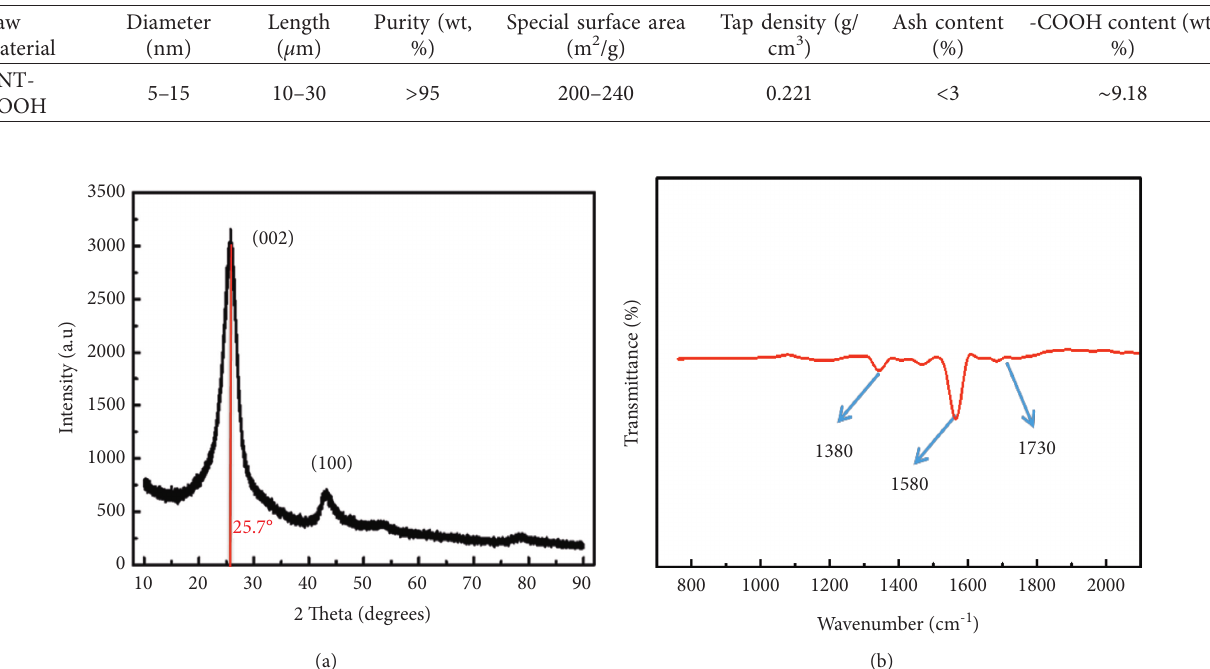
Table 3: Properties of carboxyl multiwalled carbon nanotube (CNT-COOH).